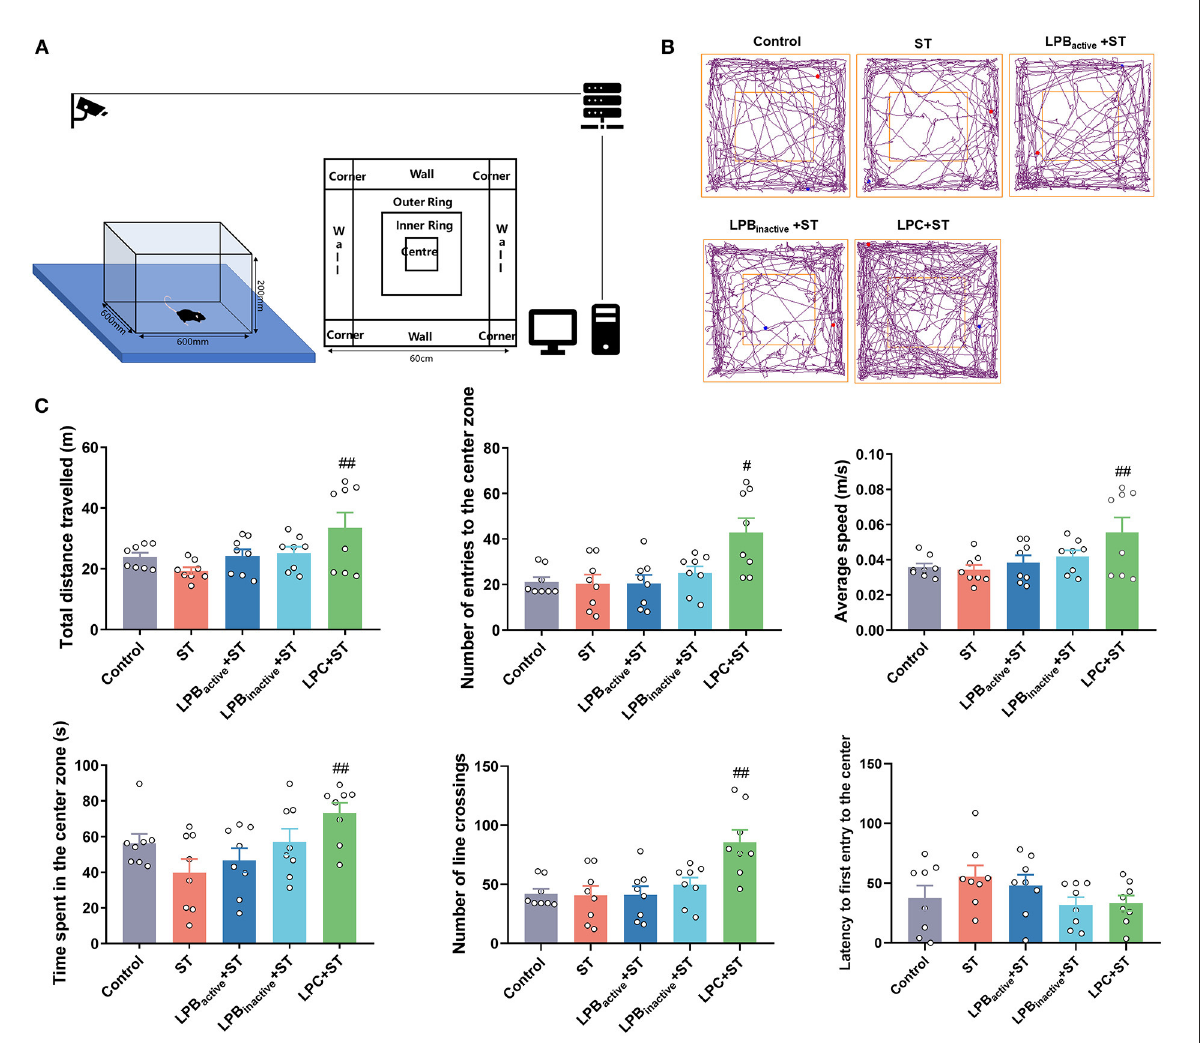
FIGURE6 The open field test (OFT) representing anxiety-like behaviors. (A) A cartoon of the apparatus for OFT is shown. (B) Characteristic tracks of mice in the light box. The blue dot represents the start point and the red dot represents the end point of the mouse activity. (C) Main data of OFT. Statistical analysis of the total distance, number of entries to the center zone, average speed, time spent in the center zone, number of line crossing, and latency to first entry to the center. The data shown as mean ± SEM were analyzed by one-way ANOVA and Tukey’s test ( N = 8 in each group). # Indicates the significance compared to ST group. # p < 0.05, ## p <